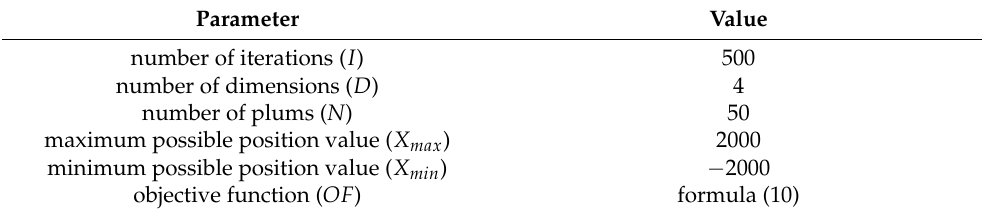
Table 10. PTA-Adapted Parameters for Ensemble Weight Optimization Summary.